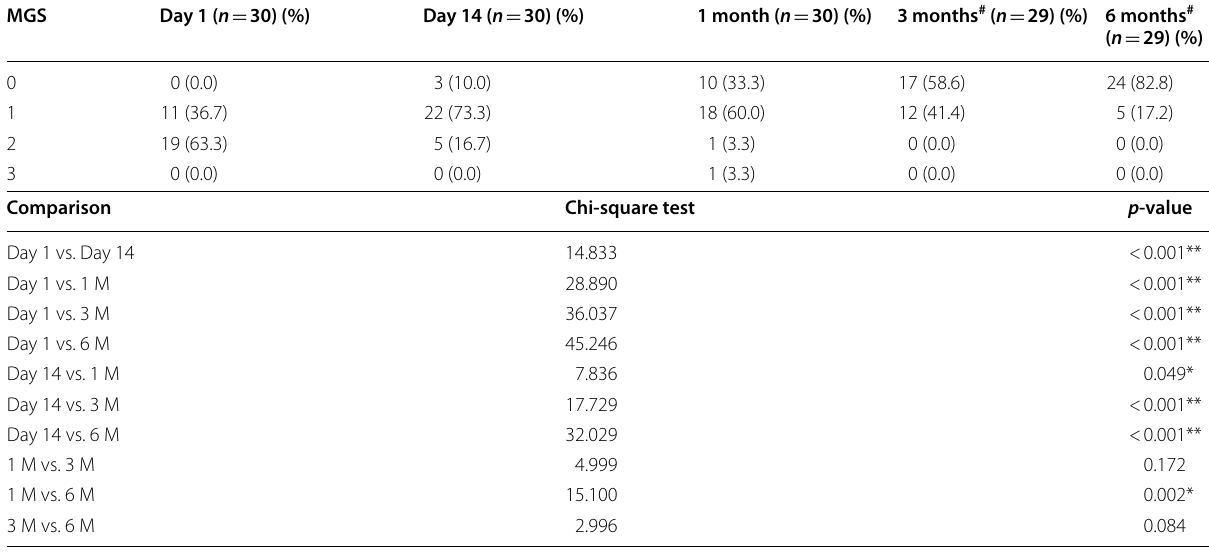
Table 3 A MGS values throughout the study duration. B Comparison between MGS values among study group ( n study duration